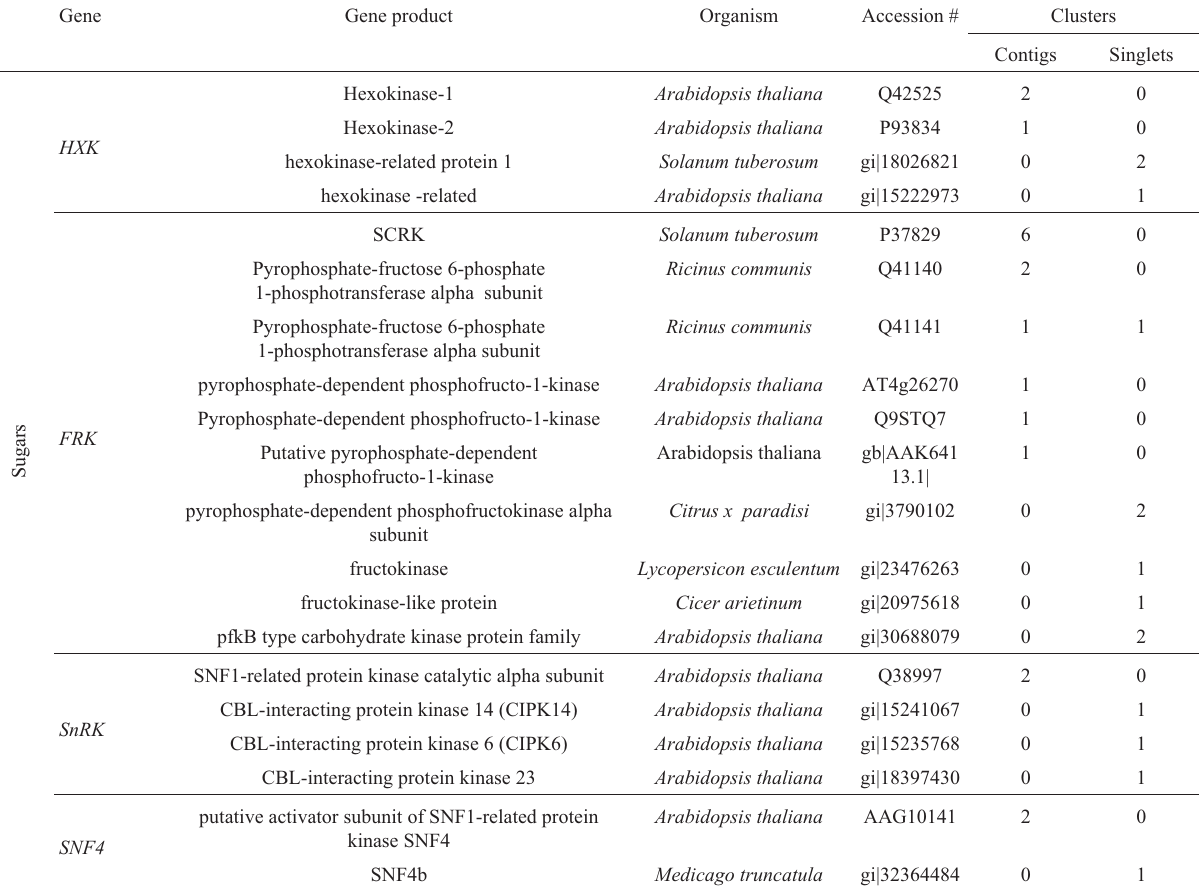
Table 5 - Ortholog genes of sugar signaling pathways found in the Citrus EST database.